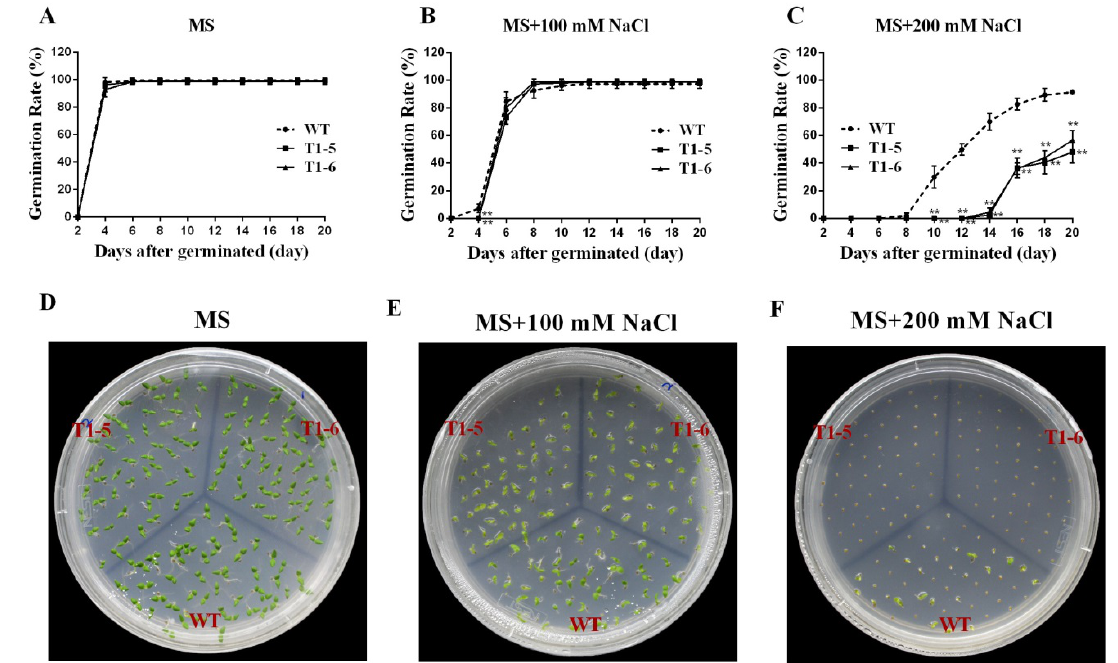
Figure 7. Effects of NaCl application on germination rates between wild-type (WT) and transgenic plants. Fifty seeds of WT and T1 transgenic plants were sown on sterile MS solid medium supplemented with different concentrations of NaCl ( A – C ). Values are means ± SD ( n = 3). The photographs ( D and E ) were taken after being sown for 9 d, photograph F was taken after being sown for 13 d. * and ** Significant at p < 0.05 and p < 0.01 compared with WT, respectively.